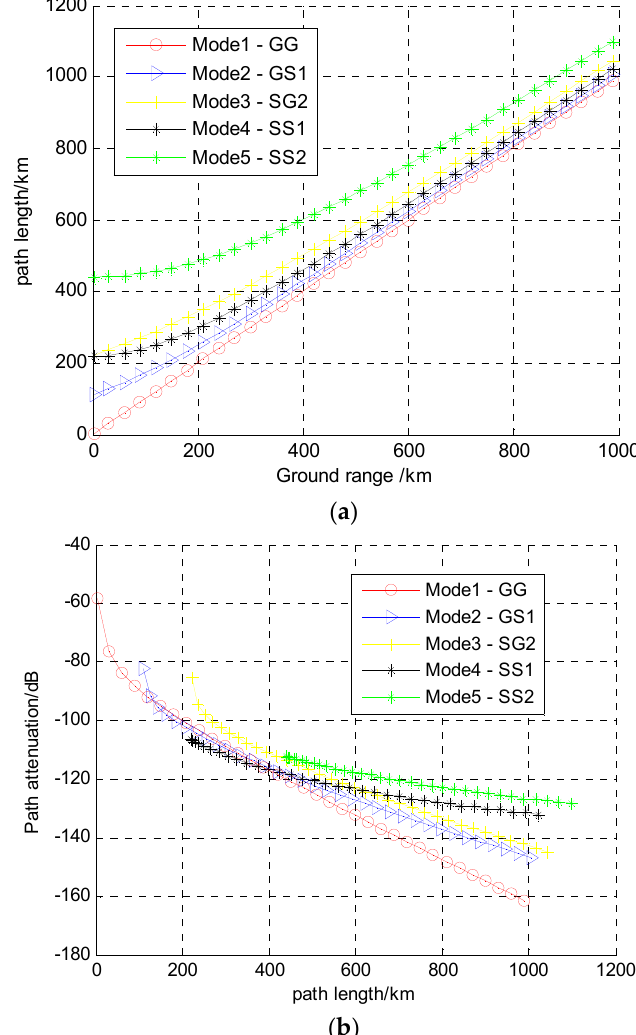
Figure 3. ( a ) Five modes’ path lengths as a function of the ground range; and ( b ) the path attenuation in five propagation modes changing with the path length.